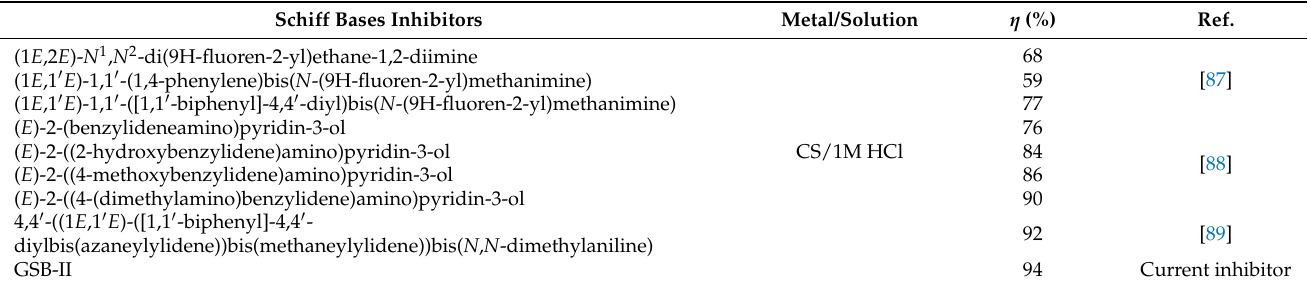
Table 7. Comparison of the inhibition efficiencies ( η %) of GSB-II with other Schiff bases. Schiff Bases Inhibitors Metal/Solution η (%)